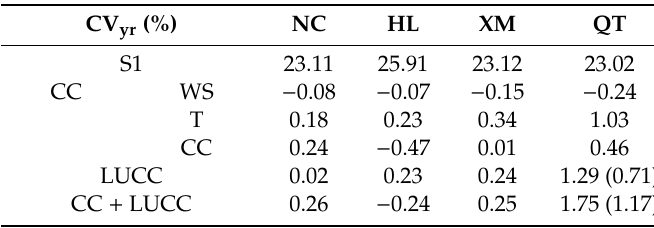
Table 7. The coe ffi cient of variation in annual average streamflow (CV yr ) of S1 and the impacts of wind speed, temperature, climate change, land use / cover change, and both climate change and land use / cover change on CVs at four stations.